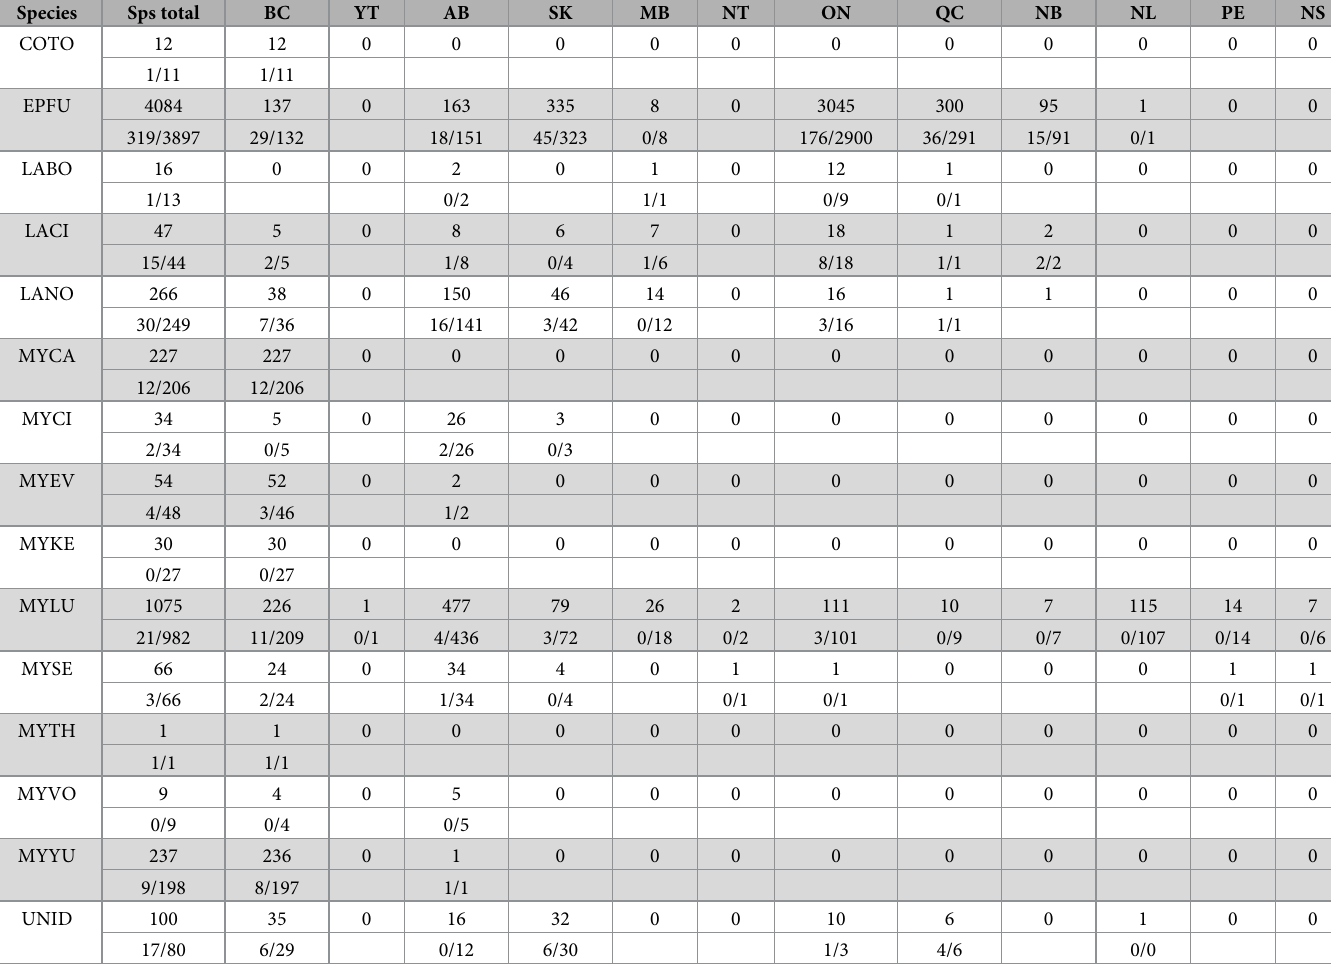
Table 1. The total number of bats (top) and the number of rabies-positive bats relative to total samples fit for testing (bottom) submitted to the CFIA during 2014– 2020 summarized by province and bats species. Bat species codes are discussed in